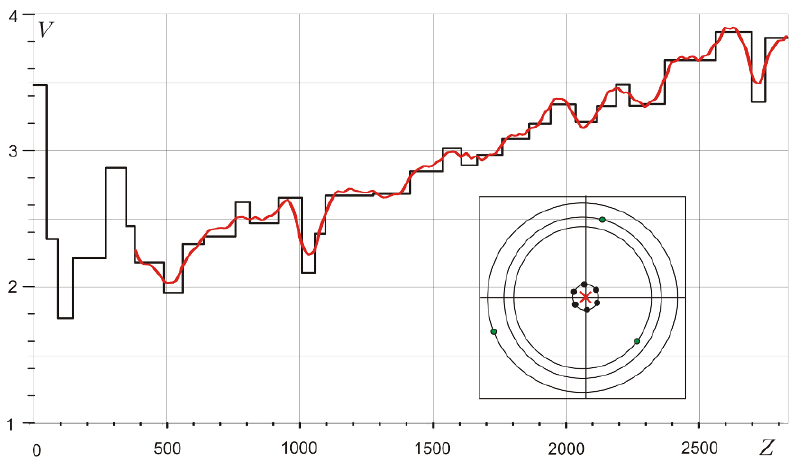
Figure 2. The dependence of the velocity on depth. The real